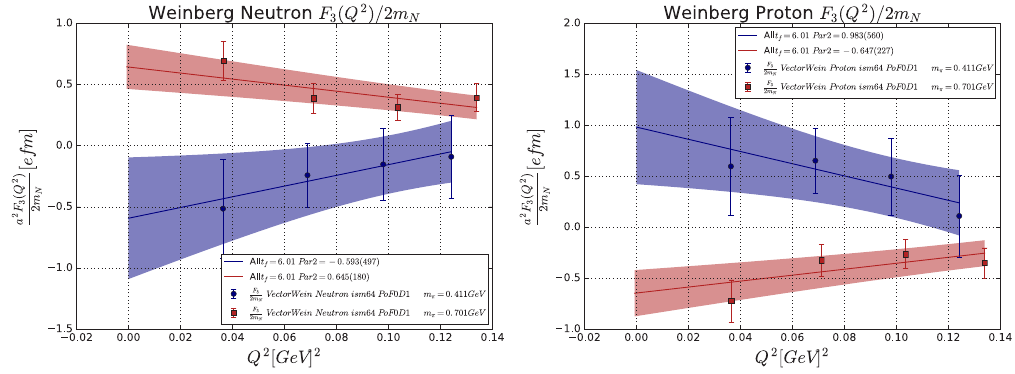
Figure 4. CP-odd vector form factor F 3 / 2 m N in units of α W / Λ 2 for the neutron (left) and proton (right), induced via the Weinberg operator CP-violating vacuum, plotted against transfer momentum Q 2 . Blue and red points are the m π = 411 , 701 MeV results respectively. The linear fit to Q 2 and proton EDM d n / p .